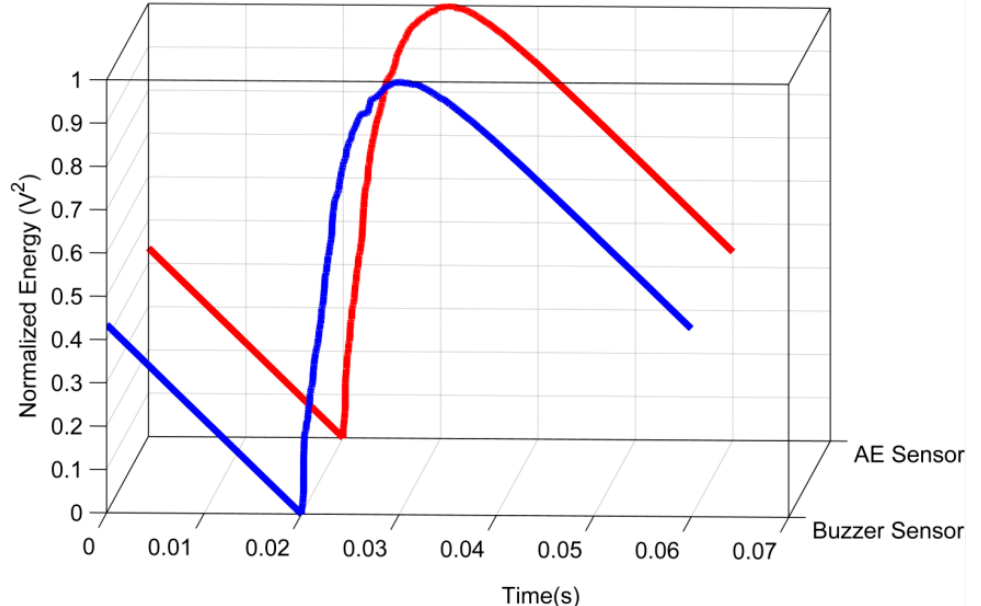
Figure 8. Energy signals of the sensors for partial discharge.